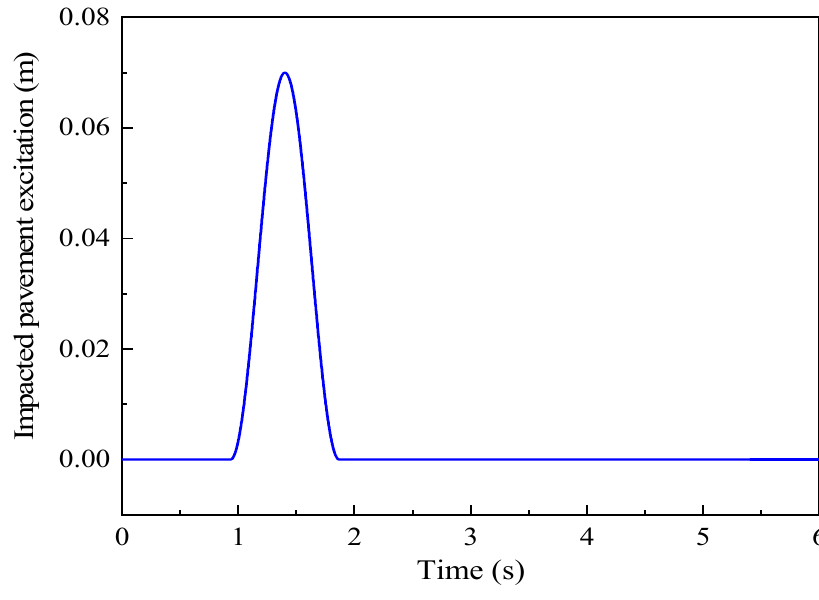
Figure 19. Impacted pavement input simulation curve. The simulation curve of the 2-DOF quarter vehicle semi-active air suspension con- trolled by FSMC impacting the road surface is shown in Figure 20. It reflects that the peak value of the FSMC-controlled semi-active air suspension is significantly reduced, compared with that of the passive and SMC-controlled semi-active air suspension under the same impact road